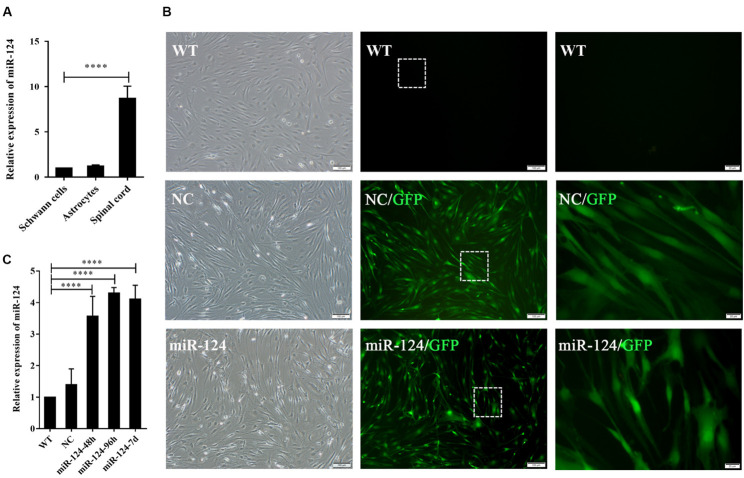
Transfection efficiency of Schwann cells (SCs) with miR-124-containing vector. (A) miR-124 expression in SCs and ASs was significantly lower than that in the normal spinal cord according to qRT-PCR analysis (n = 3, ****p < 0.0001). (B) SCs showed green fluorescence 48 h after transfection with lentivirus. No significant cell morphology change was noted. The third figure is the magnification of the white dotted box in the middle one (first and second, scale bar = 100 μm; third, scale bar = 20 μm). (C) miR-124 expression in SCs after transfection for 48 h, 96 h, and 7 days were increased fourfold than those in NC and WT (n = 4, ****p < 0.0001).